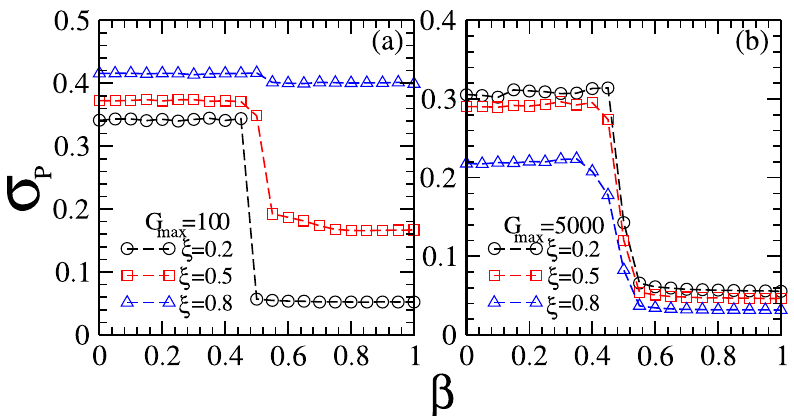
Fig 4. The standard deviation σ P of normalized stock prices as a function of market impact β for different combinations of maximal risk tolerance G of reference point strategies and the ratio ξ of individuals with max reference point strategies. (a) G = 100 and ξ = 0.2 (circles), 0.5 (squares), 0.8 (triangles); (b) G = 5000 and ξ = max max 0.2 (circles), 0.5 (squares), 0.8 (triangles). Other parameters are: the population size N = 5001, the memory size m = 3 and m 0 = 10, the updating threshold of history-dependent strategies S = 0, the maximum drift of history-dependent th strategies ε = 0.1, the liquidity l ¼ N , the constant a ¼ 10 , minimum and maximum shares holding k min = -1, k max = 1. 10 N Final data are obtained by averaging over 200 runs and 10 4 times after 10 5 relaxation times in each run. The